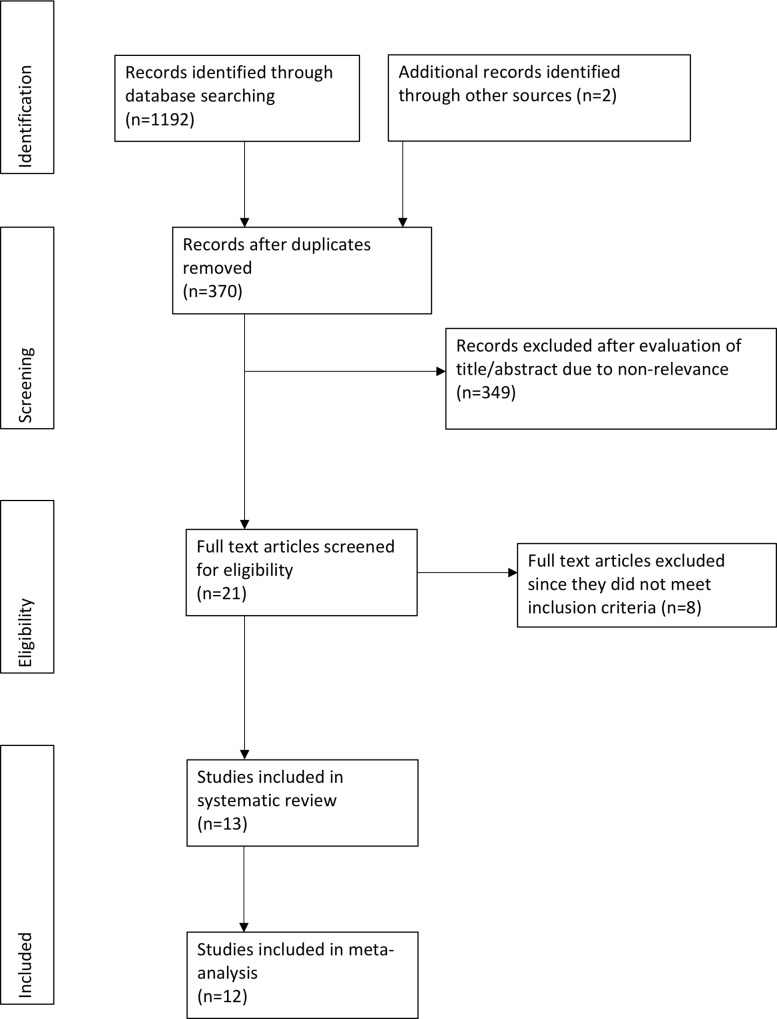
Study flow chart.